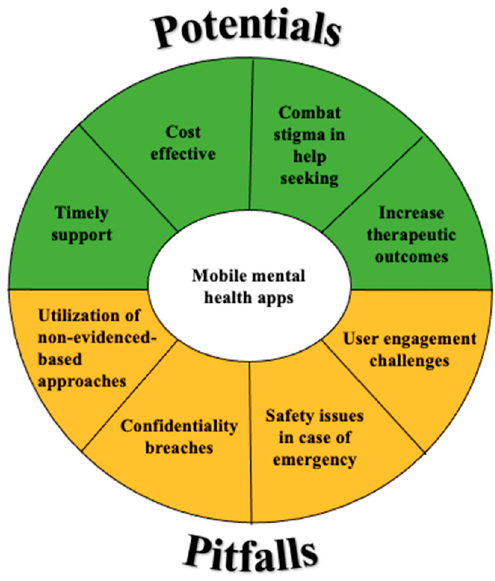
Figure 2. Potential and pitfalls of mobile mental health apps.